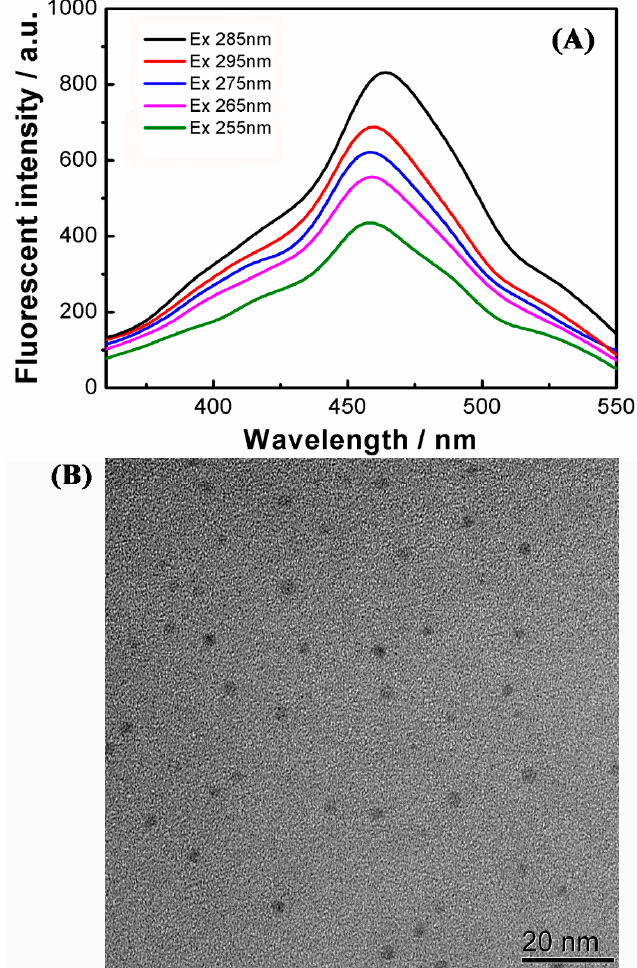
Figure 2. Fluorescence properties ( A ) and TEM image ( B ) of dopamine-functionalized fluorescent C-dots under difference excitation wavelength from 255 nm to 295 nm.